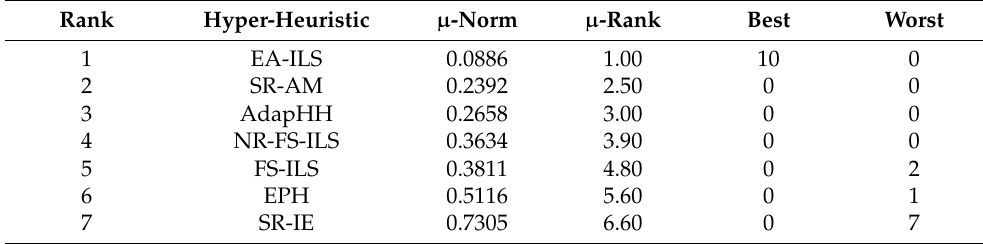
Table 7. Evaluation Results on the Maximum-Cut Problem.